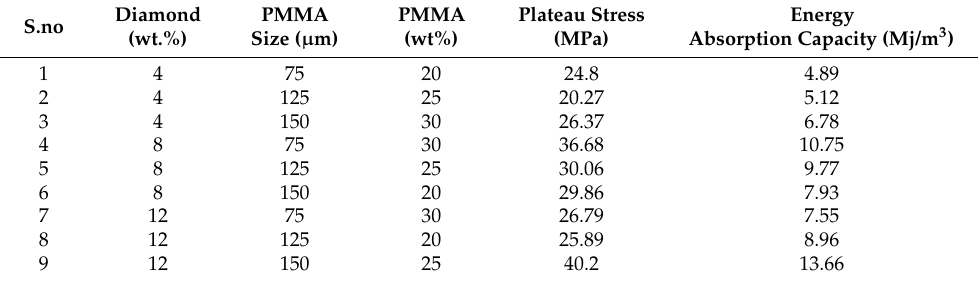
Table 3. L9 Orthogonal array layout with design